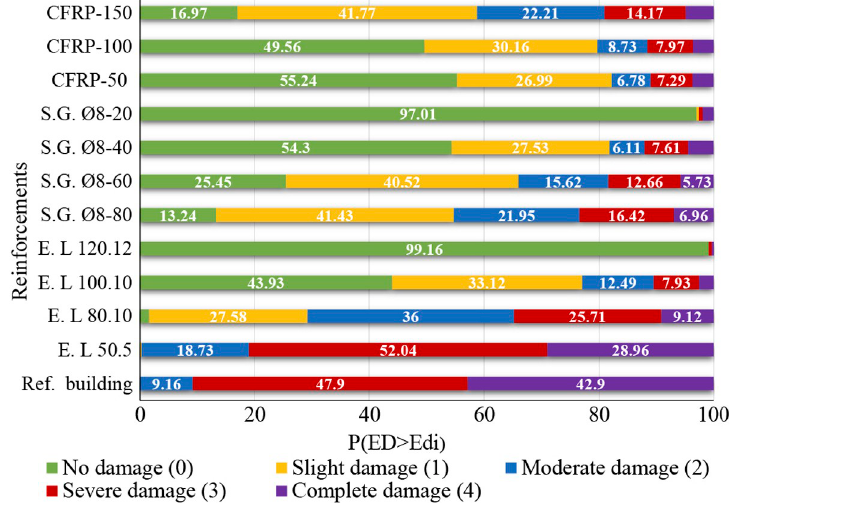
Fig 10. Damage states probabilities.